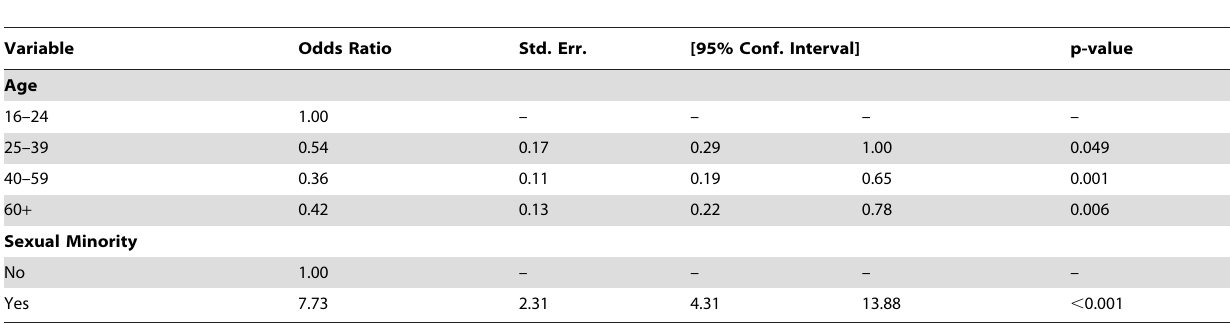
Table 5. Multivariate Logistic Regression Model for Donating to HIV and AIDS versus Other Disease or Illness Charities, among Participants who Donated to Disease and Illness Charities in the past 12 months (n= 1384, Weighted).